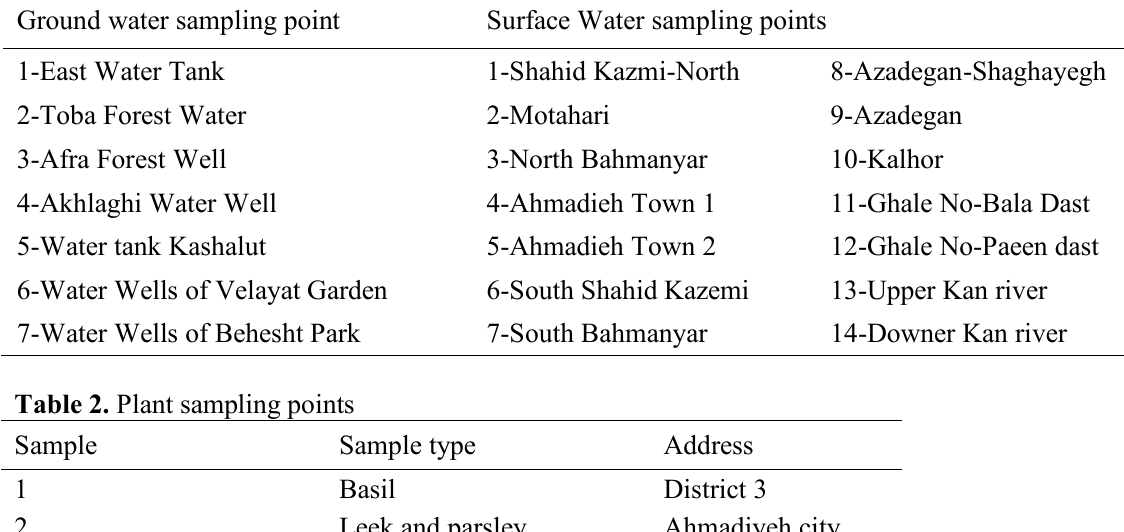
Figure 1 . Surface and underground water sampling points in the south of Tehran (19th District of Tehran) Table 1. Surface and underground water sampling points